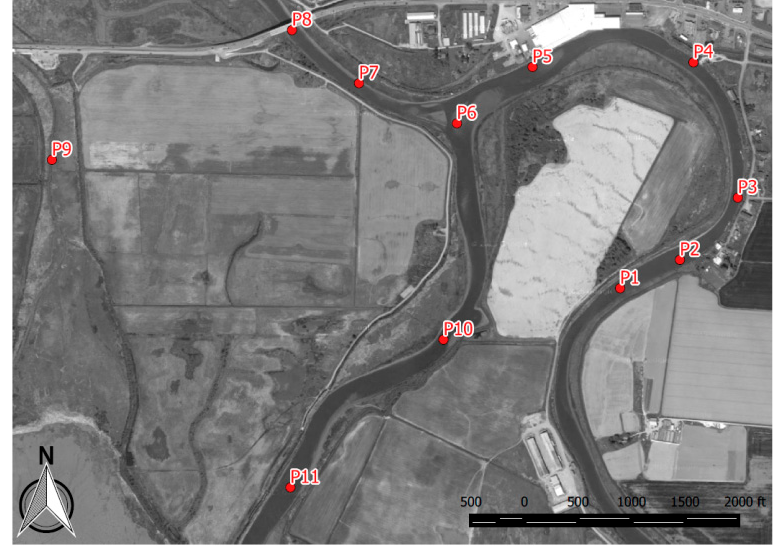
Figure 7. Eleven station locations on the Leque Island and the zis a ba sites.